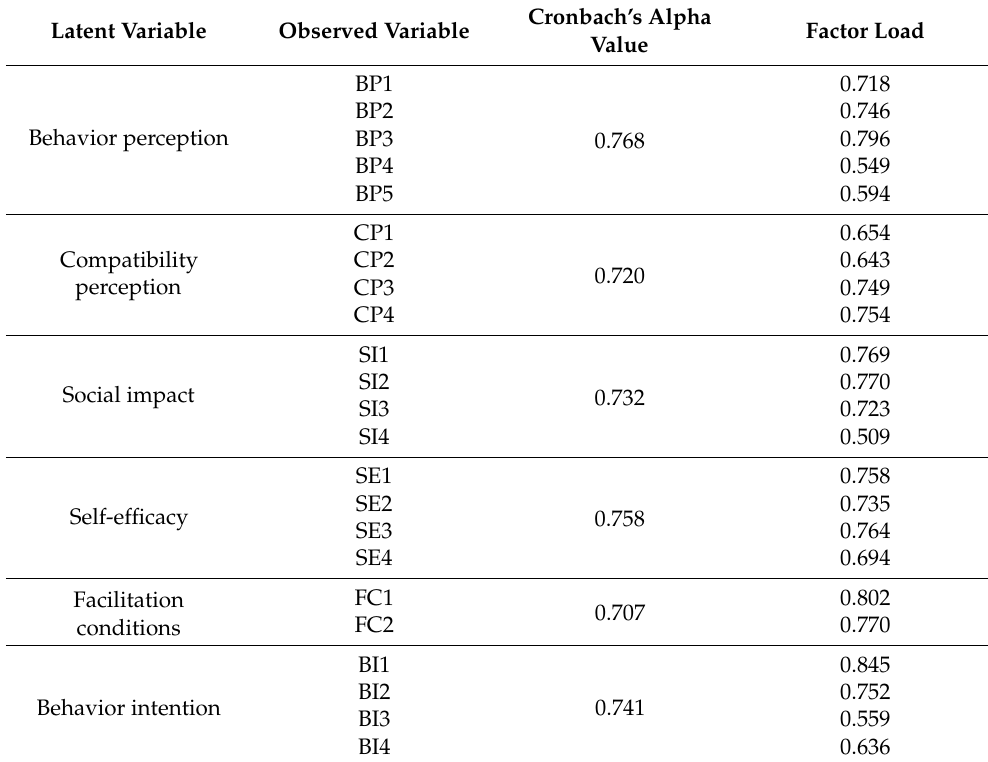
Table 4. Reliability test results and confirmatory factor